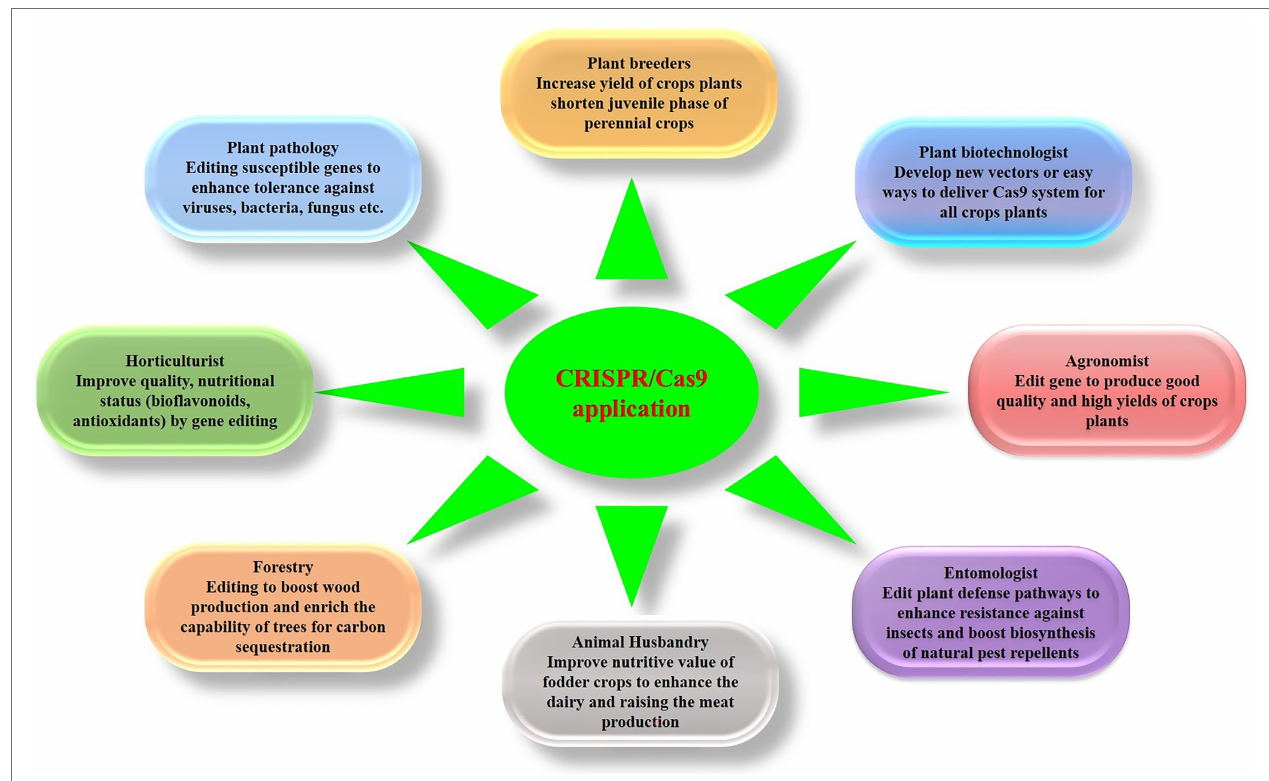
FIGURE 6 | An overview of genome engineering technology and the potential use of the CRISPR-Cas system in different agriculture science